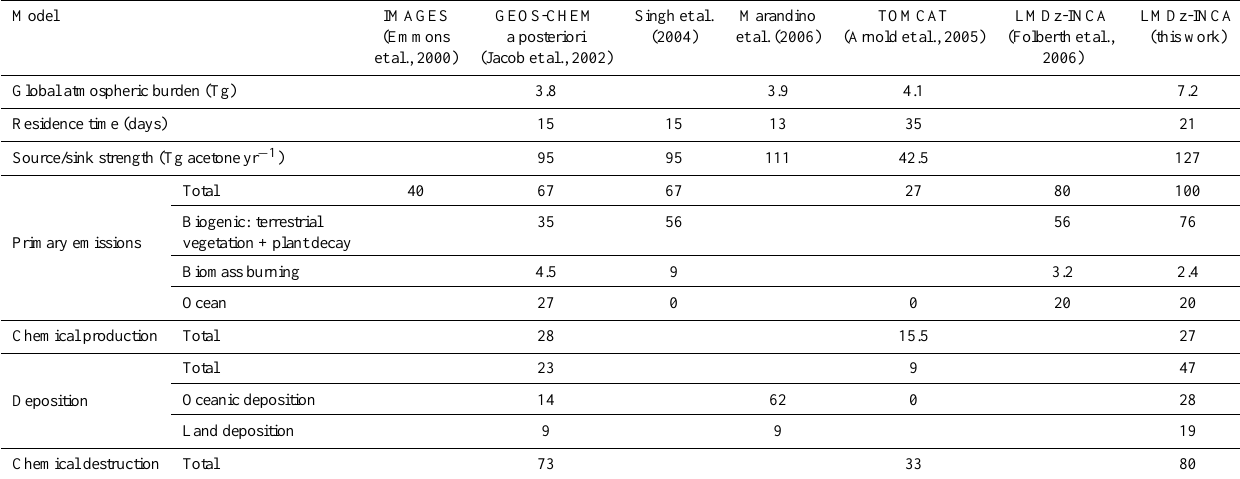
Table 1. LMDz-INCA computation of acetone global budget terms, as well as literature results. Sources correspond to primary emission and chemical production, sinks correspond to deposition and chemical destruction. Primary emission and deposition are further apportioned according to continental/oceanic